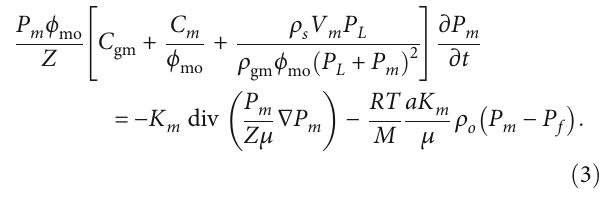
: arti fi cial fracture; Γ 3